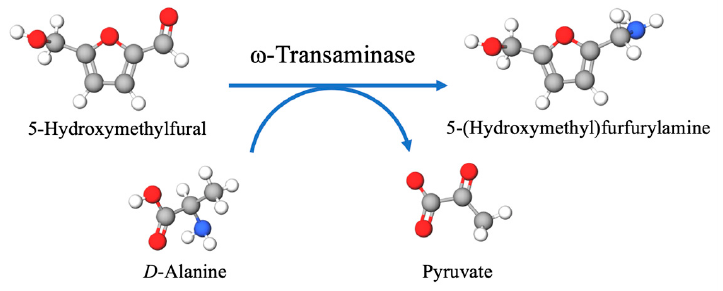
Figure 10. Bioamination of 5-HMF to 5-HMFA.